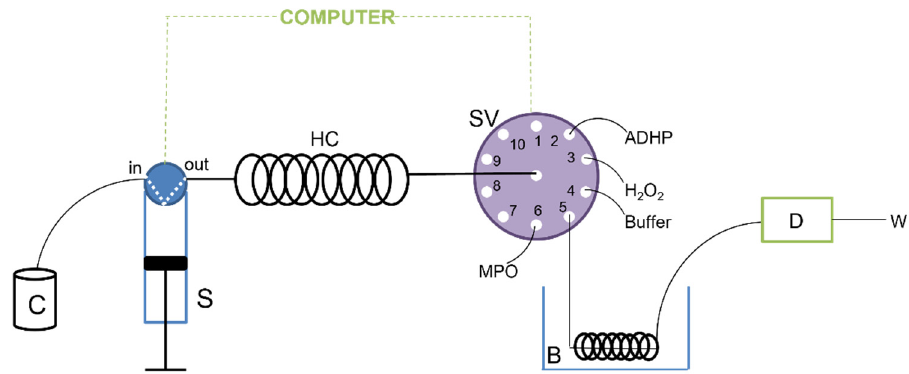
Figure 3. Schema representation of the developed SIA system. C: carrier; S: syringe; HC: holding coil; SV: selection valve; B: thermostatic bath (37 °C); D: detector; W: waste.